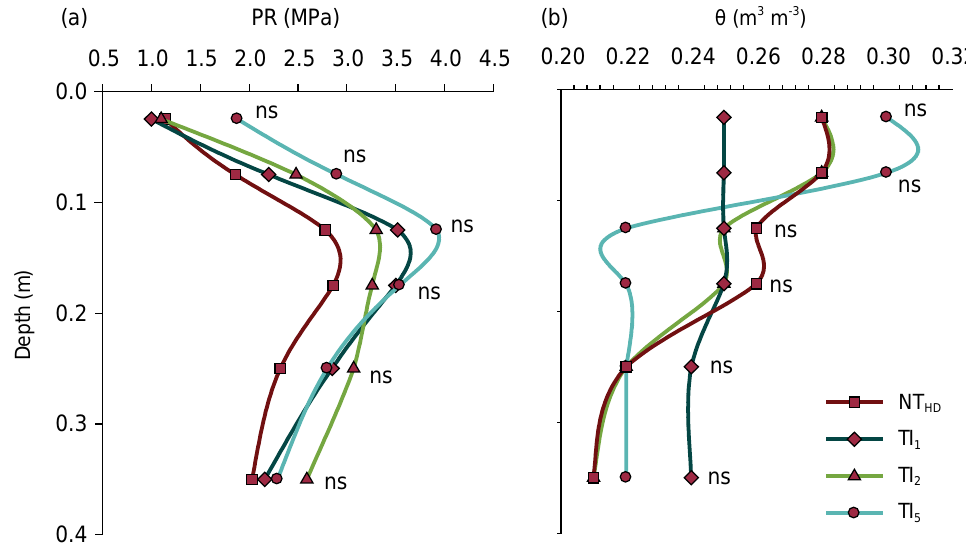
Figure 6. Soil penetration resistance (PR) (a) and volumetric water content (θ) (b) in treatments with no traffic (NT HD ) and after 1, 2, and 5 traffic (TI 1 , TI 2 , and TI 5 ) of M113 BR in a straight line. ns: not significant by Tukey test (5